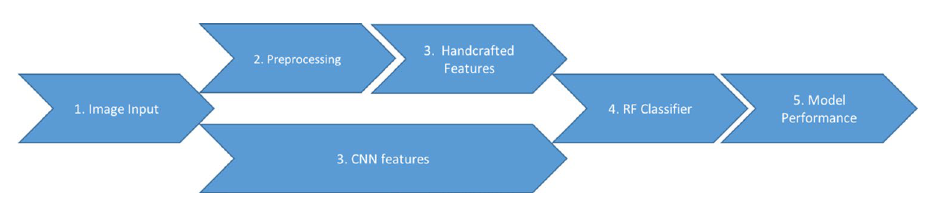
Figure 2. Study pipeline of evaluating adequacy of liver MR